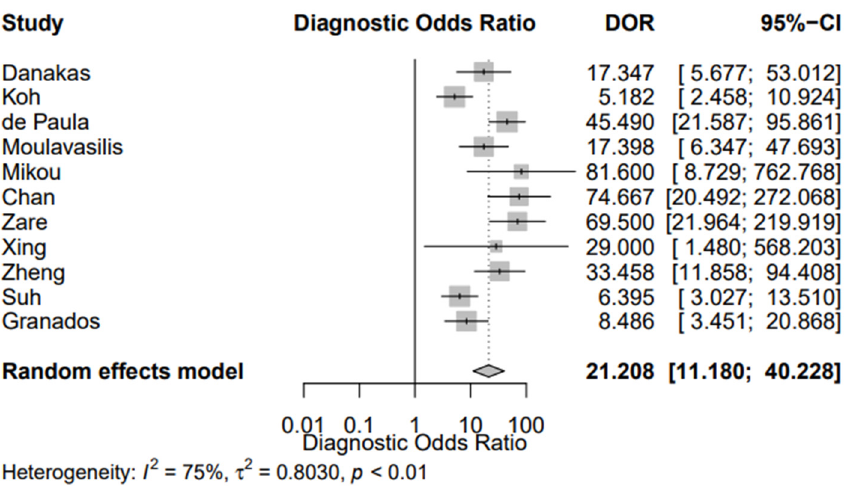
Figure 5. Diagnostic Odds Ratio (DOR) of the eligible studies using liquid-based cytology.